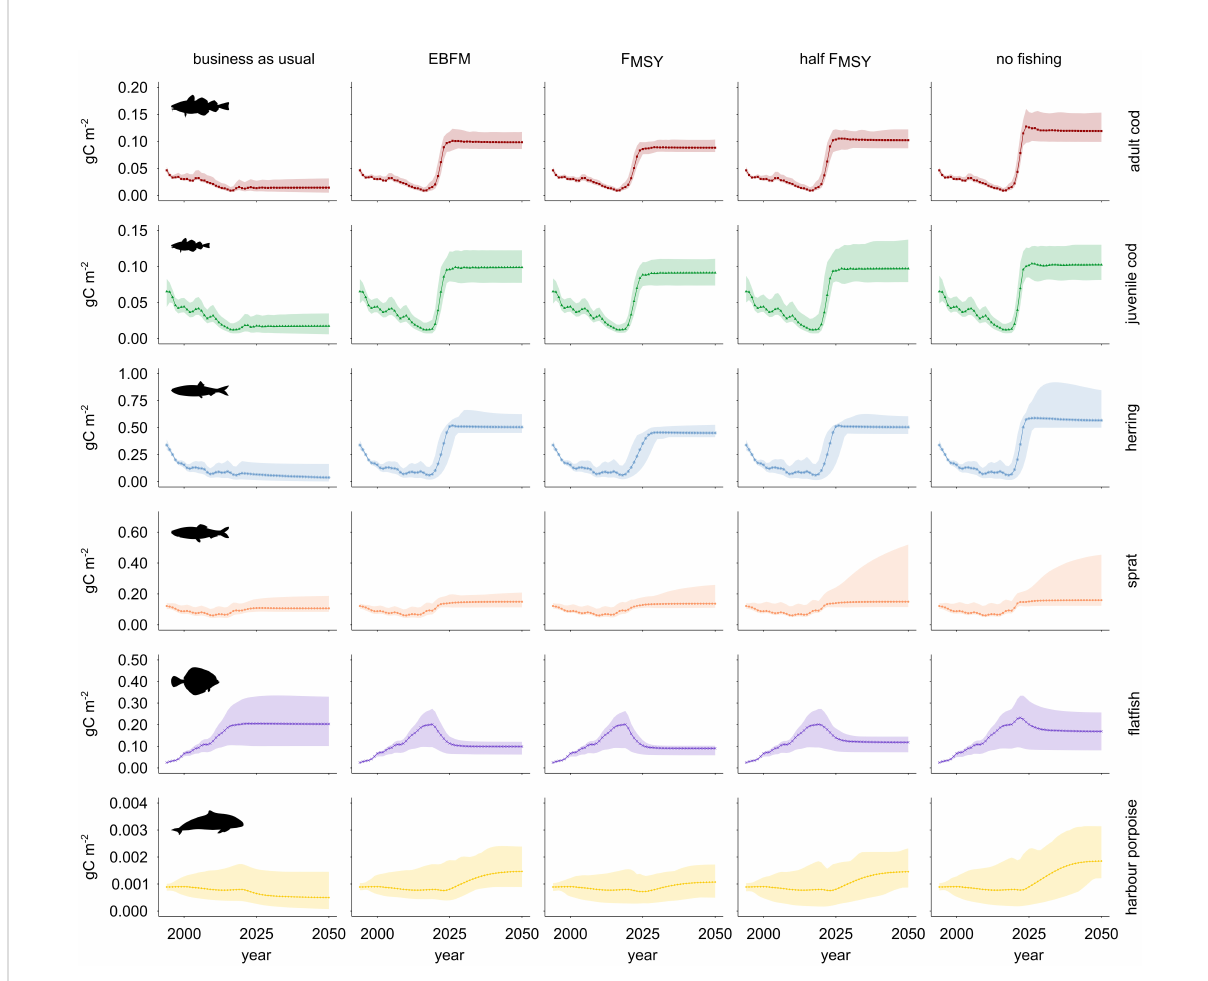
FIGURE 4 Biomass of commercially most relevant fi sh stocks and harbour porpoise in the WBS under fi ve alternative fi sheries management scenarios. Columns refer to fi shing regimes: business as usual (BAU), Ecosystem-Based Fisheries Management (EBFM), maximum sustainable yield (F MSY ), half of maximum sustainable yield (F MSY ), and no fi shing. Rows show trends for the trophic groups. Solid lines depict the predictions generated using the reference model while shaded areas indicate approximate 95% con fi dence limits. Under BAU, fl at fi sh and sprat dominate the ecosystem thus con fi rming the regime shift triggered by over fi shing during the last decades. All other scenarios lead to the recovery of the cod and herring stocks. BAU is incompatible with the preservation of a healthy harbour porpoise